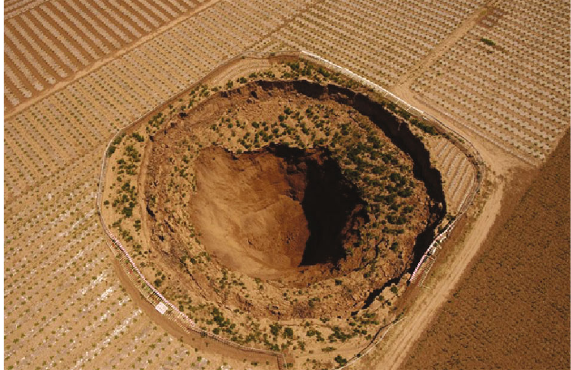
Figure 5: Large scale surface subsidence